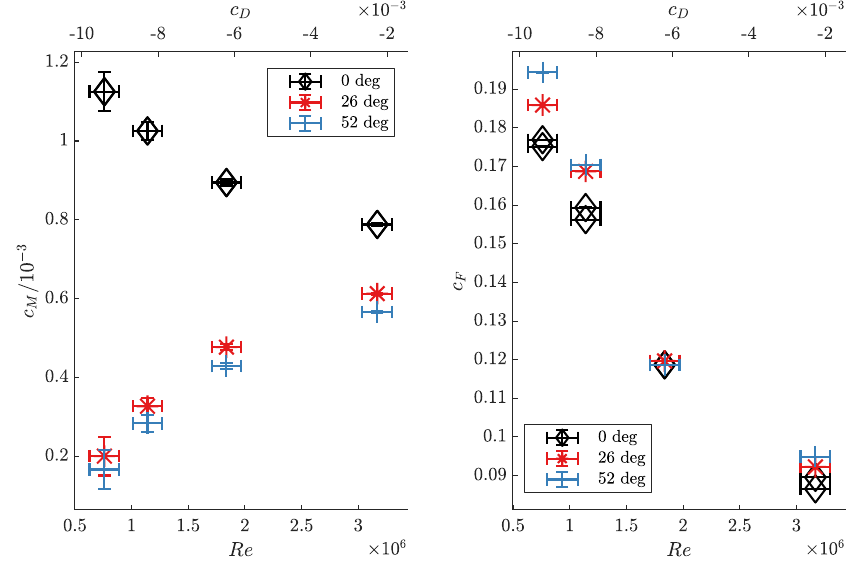
Figure 11. The influence of the preswirl angle on torque ( c M ) and axial thrust coefficients ( c F ) in the small test rig (compare [10]) with the relative cavity width set to G = 0.0182. For the results shown here, the product of through-flow coefficient c D and Reynolds number Re is constant. The horizontal error bars refer to the Reynolds number